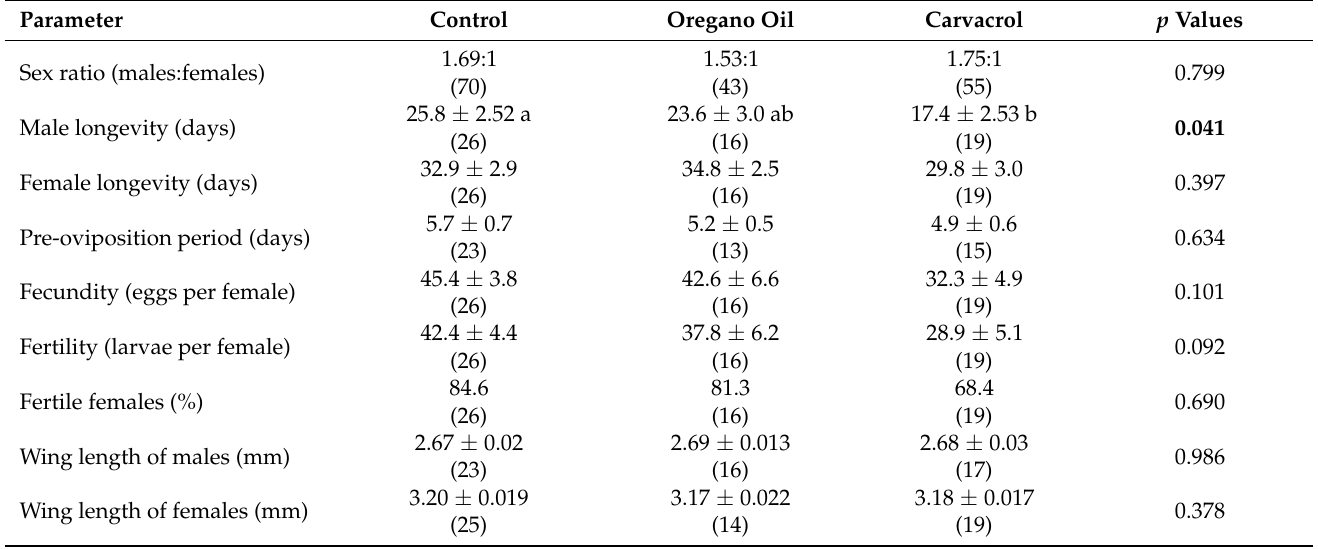
Table 2. Effects on biological parameters of Cx. pipiens biotype molestus after 24 h exposure of 3rd–4th larvae to LC 50 concentrations of oregano oil and carvacrol, and to water solution of 2% DMSO (control). Mean ( ± S.E.M.) longevity of males and females in days, pre-oviposition period in days, number of eggs per female (fecundity), number of larvae per female (fertility), and wing length of males and females in mm, as well as sex ratio of surviving adults (males:females) and % of fertile females (females that gave